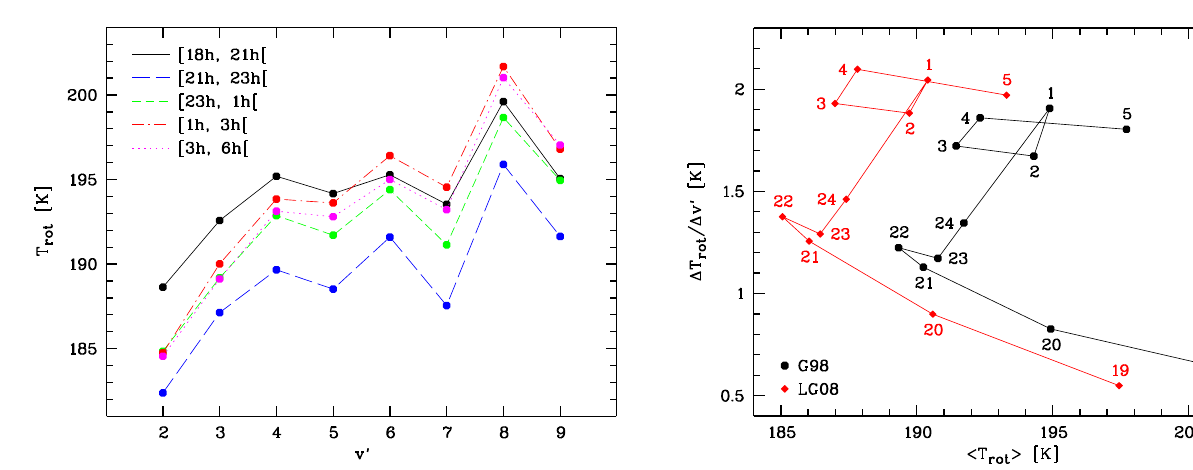
Figure 10. Change of T rot with v (cid:48) (cid:49)T rot /(cid:49)v (cid:48) (slope of regression line) as a function of the average (cid:104) T rot (cid:105) of all v (cid:48) for local time bins centred on the hour (see labels). The plot is based on the T rot (v (cid:48) ) of the individual spectra. Results are shown for the G98 (black filled circles) and LG08 line parameters (red filled diamonds), respec-